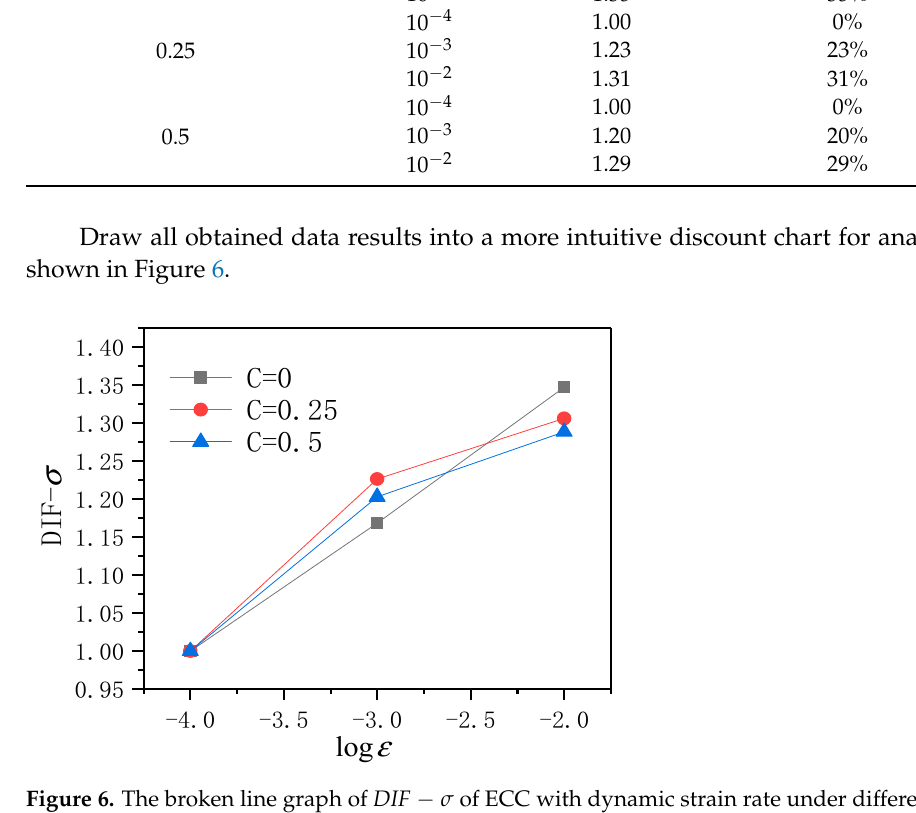
Figure 6. The broken line graph of DIF − σ of ECC with dynamic strain rate under different lateral pressure levels.